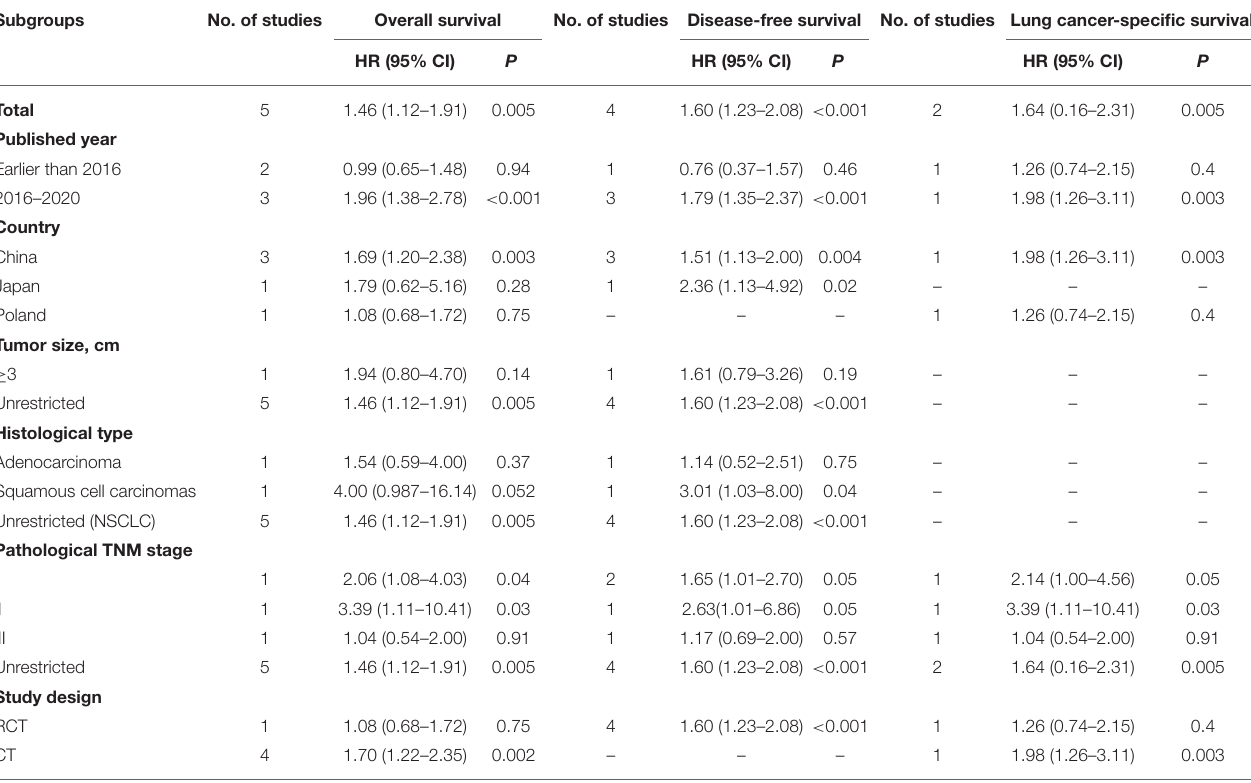
TABLE 3 | Subgroup analysis of survival (OS, DFS, and LCSS) in the comparison of Vein-first vs. Artery-first for lobectomy. Subgroups No. of studies Overall